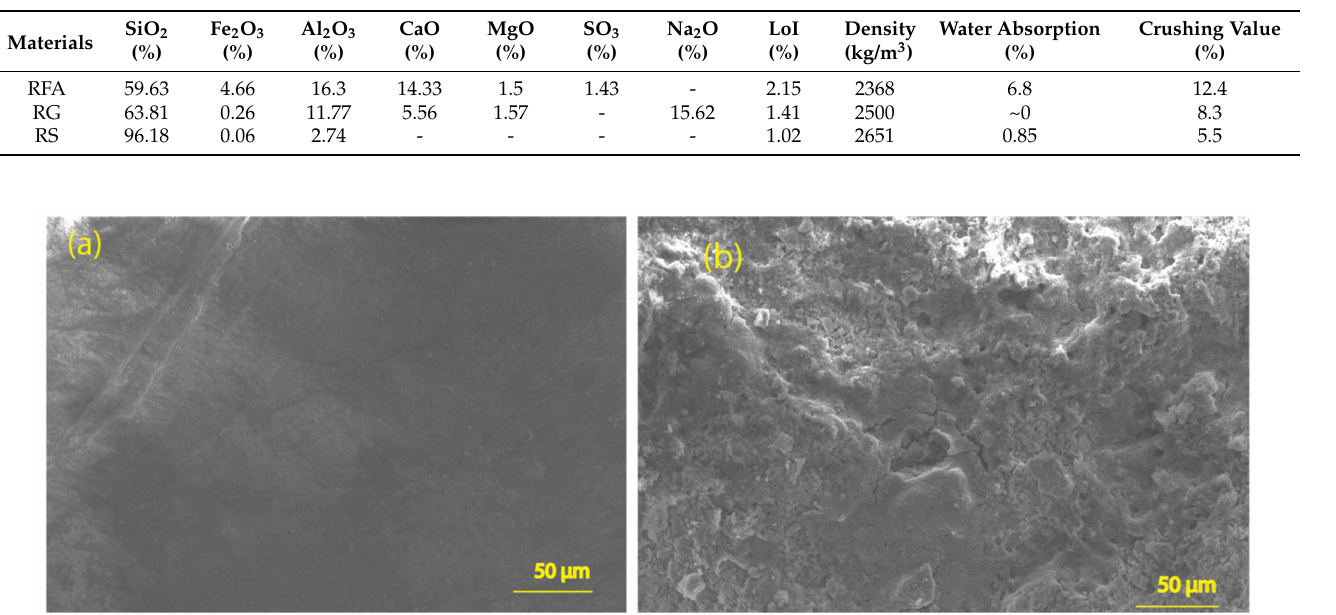
Table 2. Chemical composition and physical properties of raw materials (RFA, RG and RS).